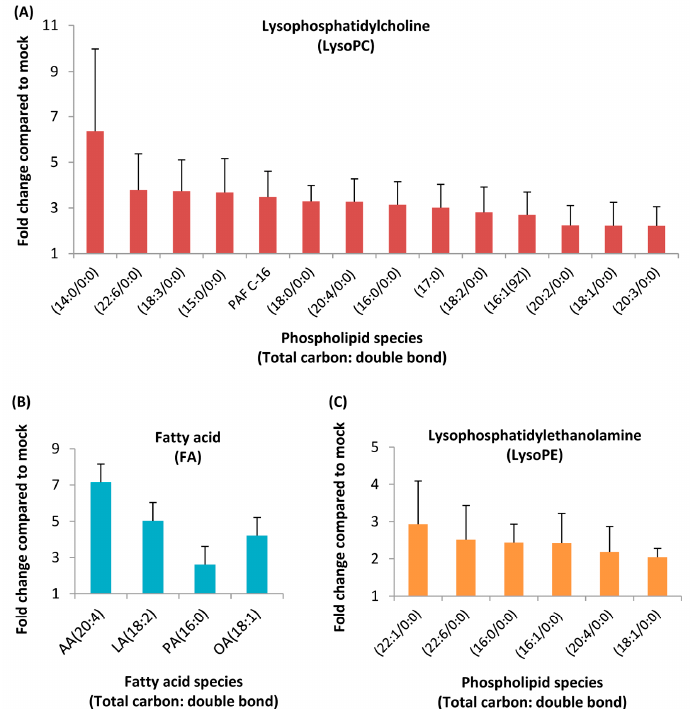
Figure 2. Liquid chromatography-mass spectrometry (LC/MS) analysis of HCoV-229E-infected cells revealed a homeostatic change in lipid levels. Huh-7 cells were mock- or HCoV-229E-infected and harvested at 24 hpi. The peak heights of these lipids were calculated and the fold change plotted with GraphPad Prism 5. ( A ) Lysophosphatidylcholine (LysoPC), ( B ) fatty acid (FA), ( C ) lysophosphatidylethanolamine (LysoPE). AA, arachidonic acid; LA, linoleic acid; PA, palmitic acid; OA, oleic acid.